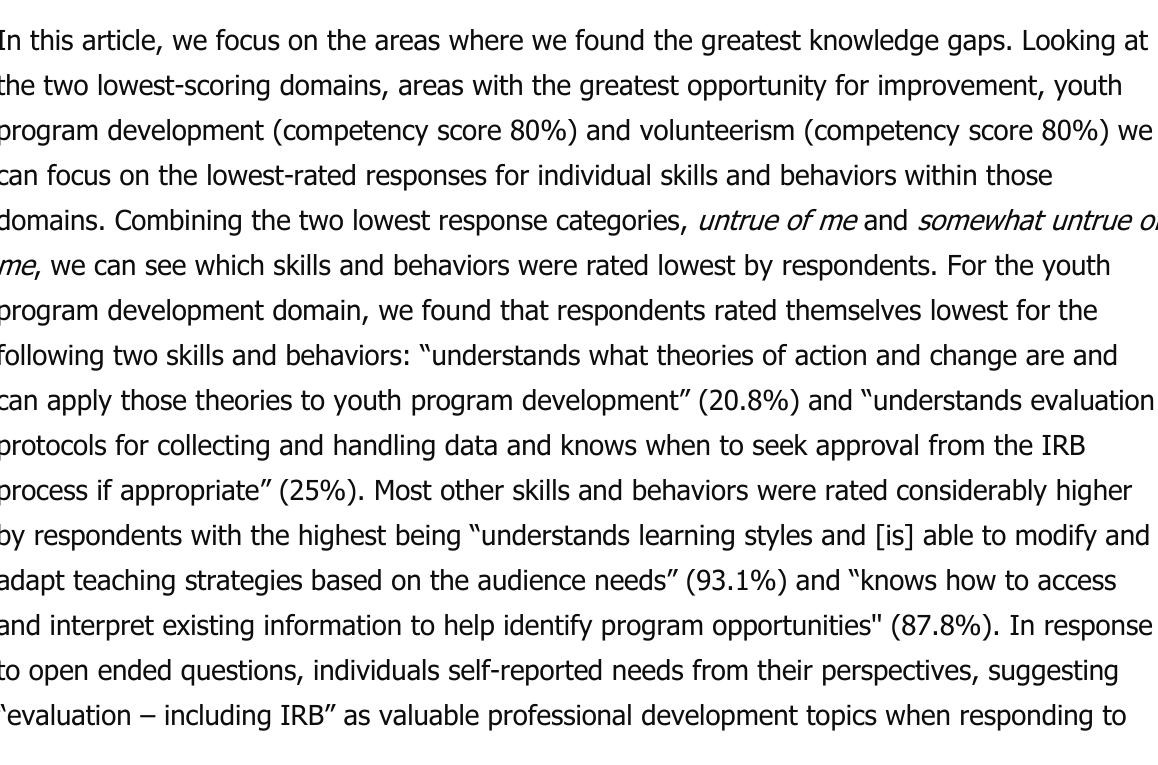
Note. Chi-square (9 df) = 17, p =